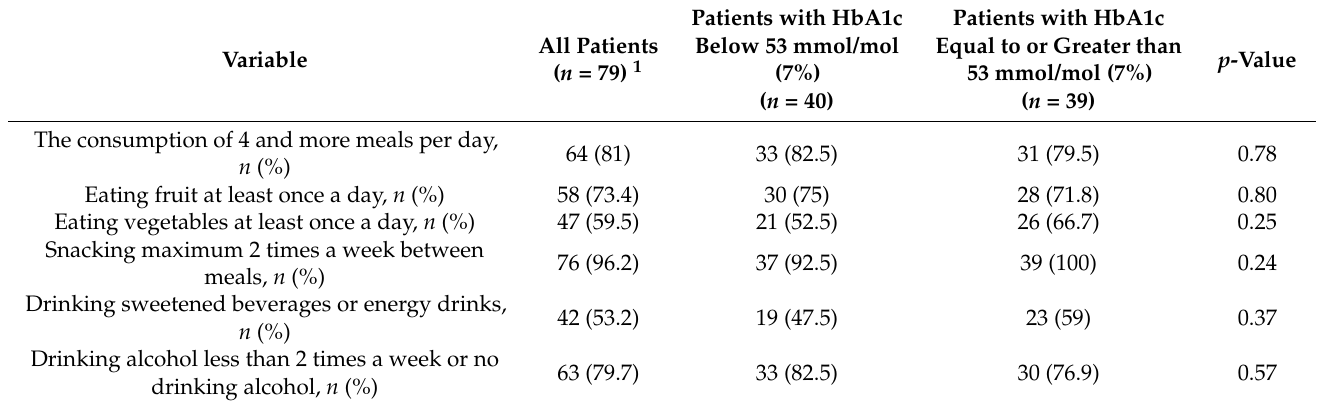
Table 2. The comparison of eating habits between patients with glycosylated hemoglobin below and equal to or greater than 53 mmol/mol (7%).